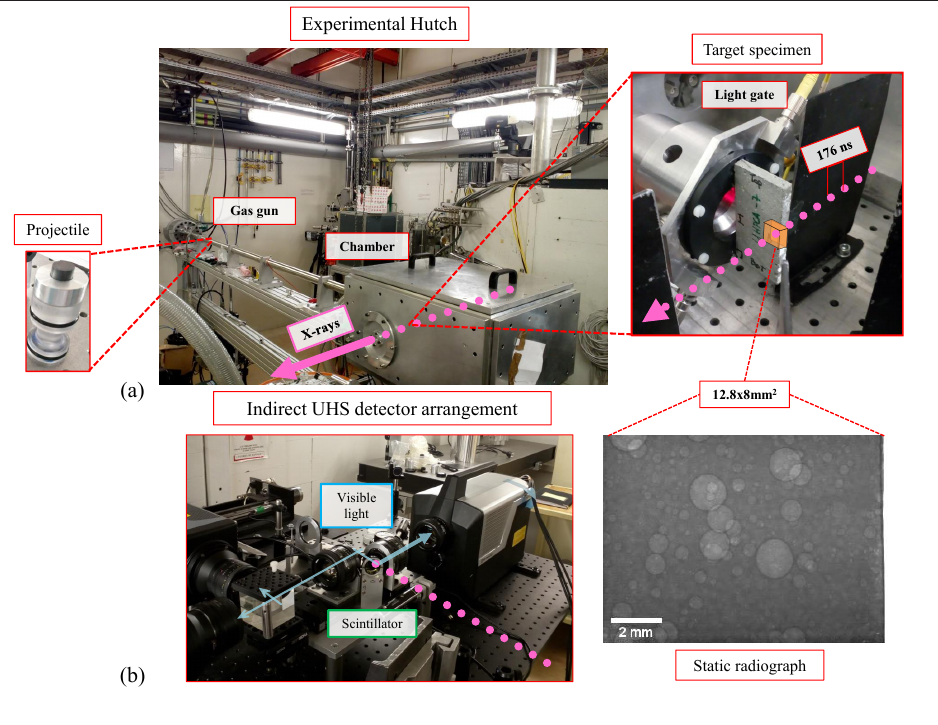
Figure 1: Experimental gas gun setup at ID19: a) Experimental beamline hutch; b) Optical arrangement of the ultra-high speed indirect detector